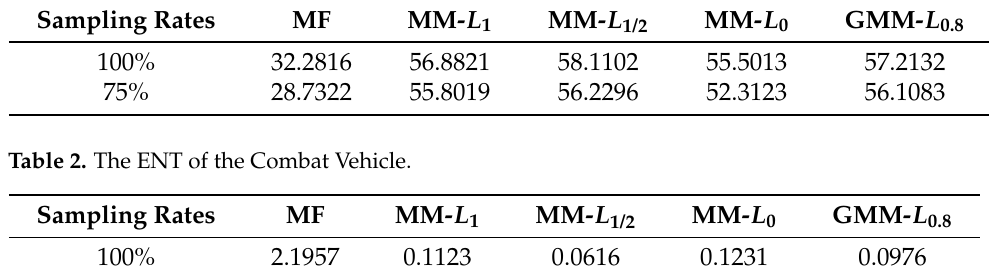
Table 1. The TBR of the Combat Vehicle.